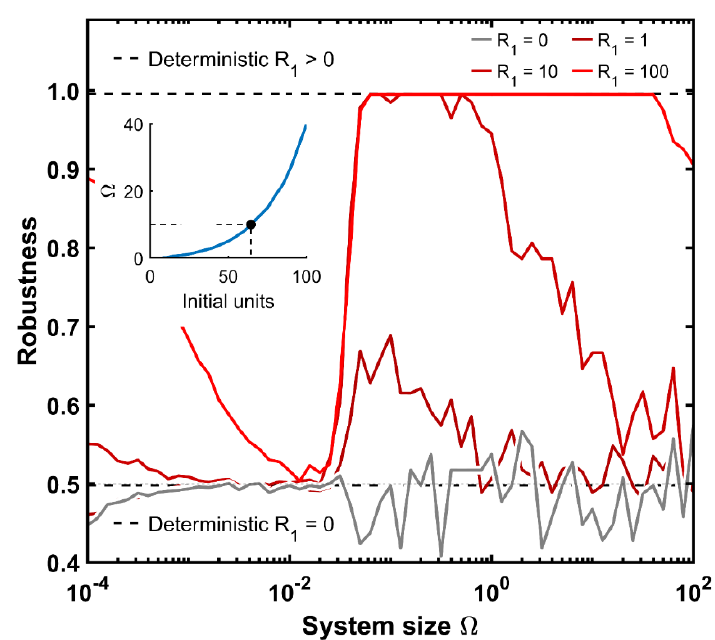
Figure 6. The robustness of the FSM is depicted as a function of the system size and for different R 1 initial protein levels while the others are absent. The robustness of the deterministic system for R 1 equal to or greater than zero is also shown. The inset plot displays the relationship between the minimal amount of repressor units at the beginning of the experiment for a coherent operation of the FSM with respect to the maximal system size. A typical value of the protein content for a living cell is highlighted.